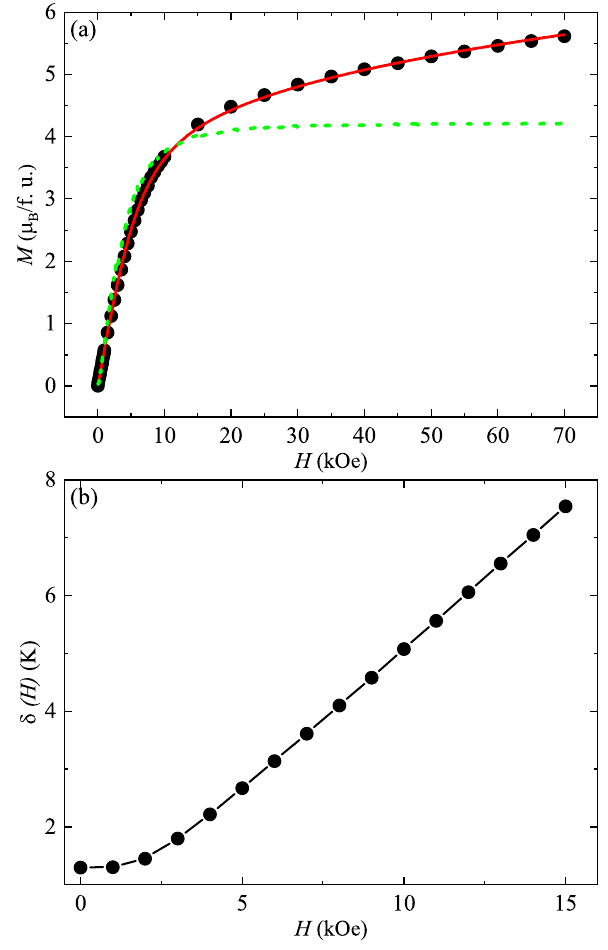
Figure 6. ( a ) M ( H ) curve obtained at 2 K. The dash green and solid red lines show the fit to the Eqs. (13) and (14), respectively. ( b ) The splitting of the pseudo-doublet ground state ( δ ) as a function of applied H calculated by solving the Eq.